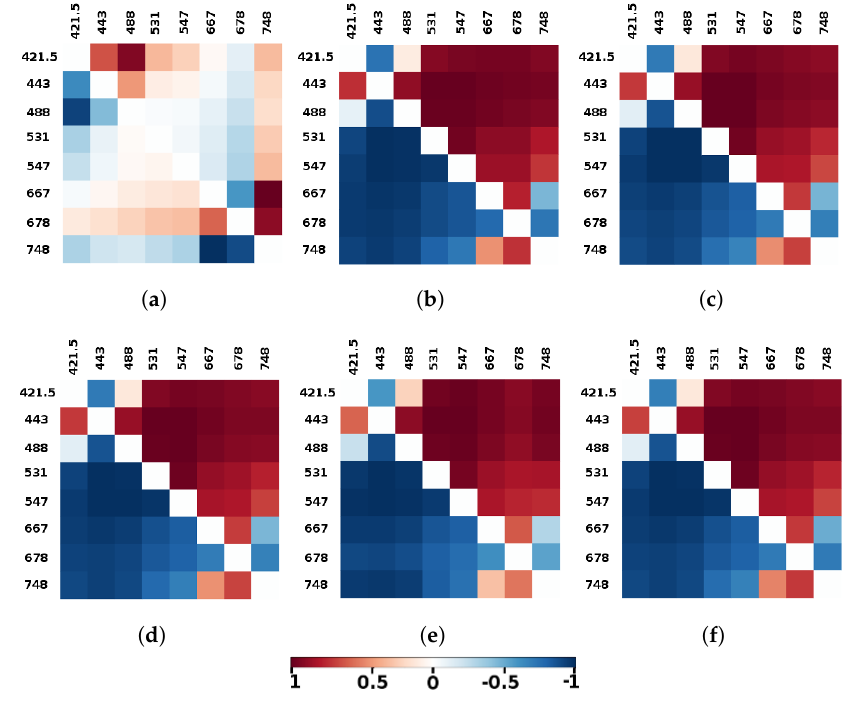
Figure 4. Correlation matrices depicting relationships between combinations of logarithms of the MODIS remote sensing reflectance band ratios and logarithms of the relevant water